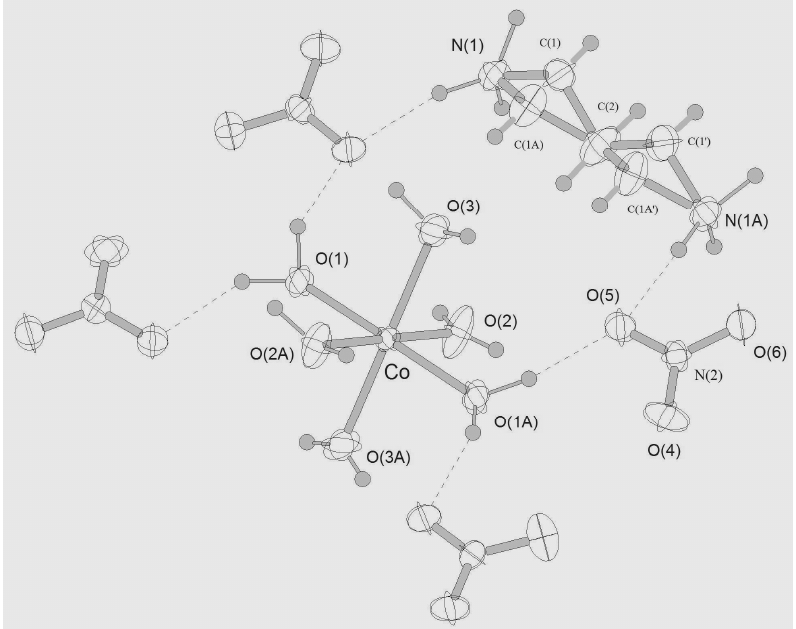
O) [C H N ] (NO ) with atom labels and 50% 2 6 3 12 2 3 4